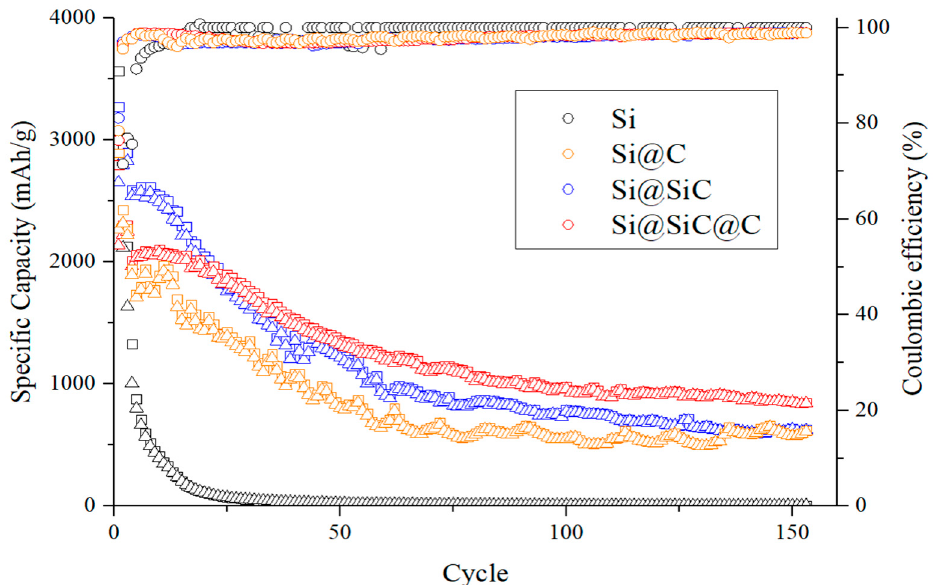
Figure 12. Cycling performance of anodes made of (black) pristine silicon flakes, (orange) silicon flakes with an RF carbon coating, (blue) silicon flakes with SiC coatings, (red) silicon flakes with combined SiC and RF carbon coatings.